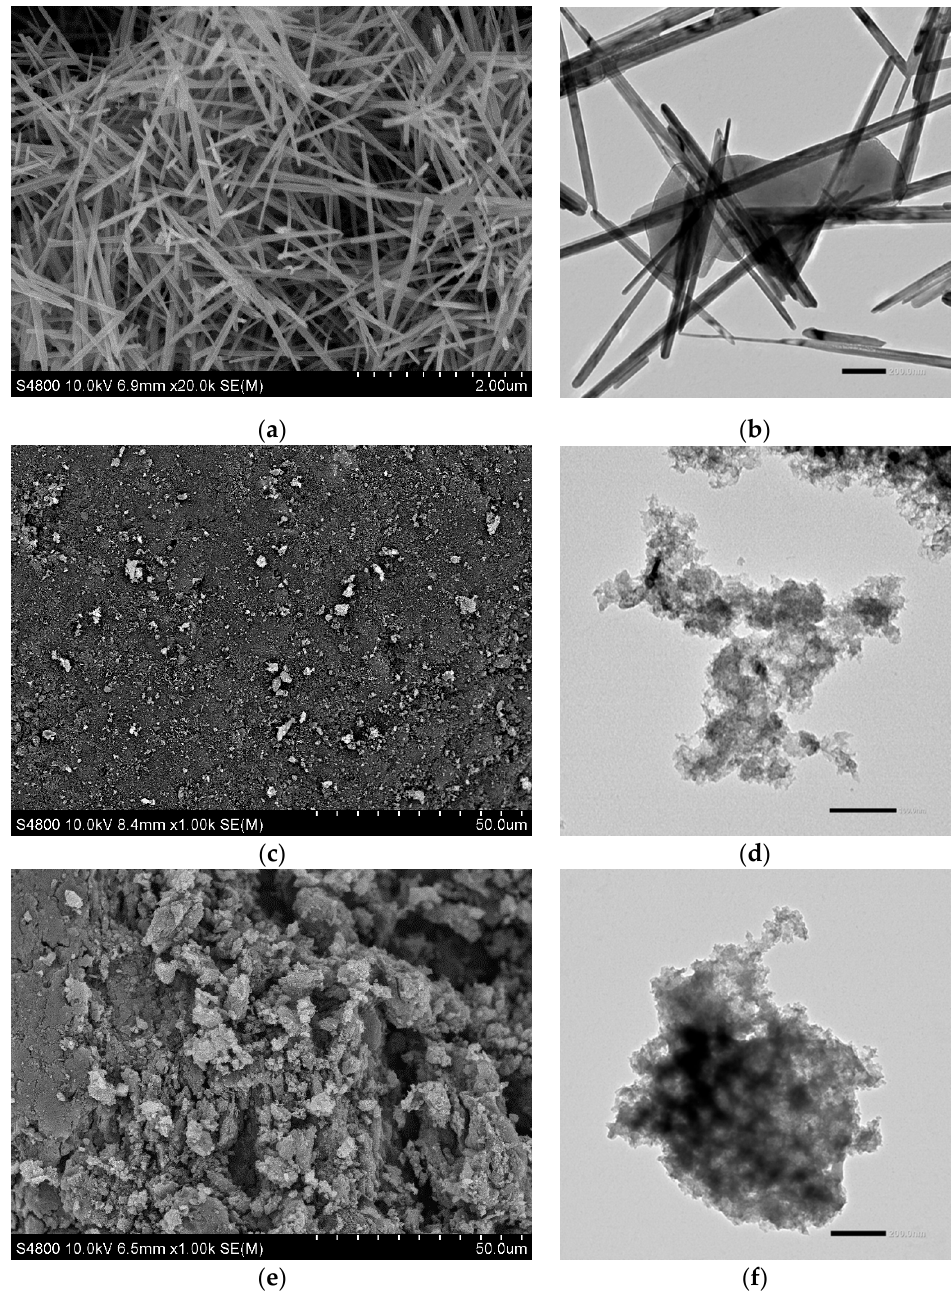
Figure 2. SEM (left) and HRTEM (right) micrographs of structures: ( a , b ) α -MnO 2 nanoparticles; ( c , d ) commercial activated carbon Hydrodarco ® 3000; ( e , f ) synthesised MnO 2 /GAC-3 composite.